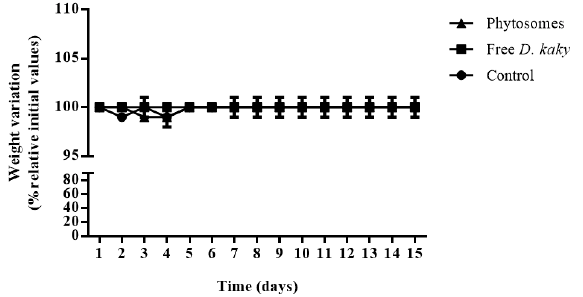
Figure 5. The variation in weight of rats during 15 days of oral administration of extract-loaded phytosomes (full triangles); free extract (full squares) and control (full circles) consisting of normal rats dosed with water. The data has been expressed by the means ± SD.